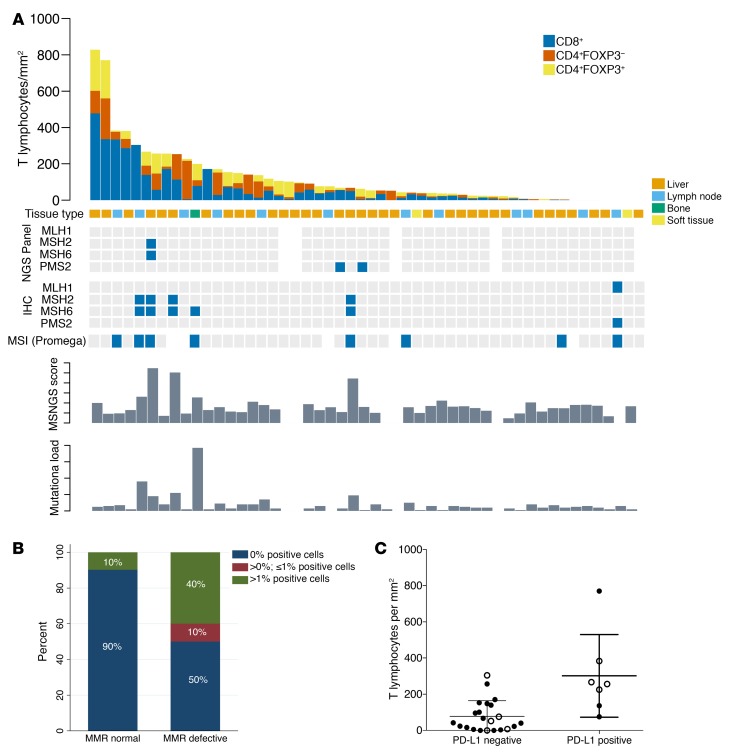
Tumor-infiltrating lymphocytes, molecular features, and PD-L1 expression of CRPC samples from RMH cohort.(A) Tumor-infiltrating T lymphocyte quantitation in 50 mCRPC biopsies, with MMR status according to the different orthogonal assays (MSI_MUT; MSI_IHC; MSI_MSINGS; mutation load), ordered from left to right by T cell infiltration score. A sample from 1 dMMR patient was not used for this analysis since it was a TURP sample taken at time of CRPC. Blue squares mark altered biomarker. (B) Stacked bar chart depicts proportion of PD-L1 immunohistochemical positivity (e.g., Supplemental Figure 3A) in samples reviewed by pathologists blinded to dMMR results in 51 mCRPC samples (n = 10 dMMR, n = 41 pMMR). (C) Dot plot showing the correlation between PD-L1 expression and T cell infiltration in mCRPC biopsies (n = 29). The y axis depicts total T cell infiltration defined as n of T cells/mm2 using a negative binomial regression model; there was an IRR of 3.91 (95% CI, 1.45–10.53; P = 0.007) for patients with PD-L1 > 0. Filled circles represent pMMR; open circles represent dMMR.